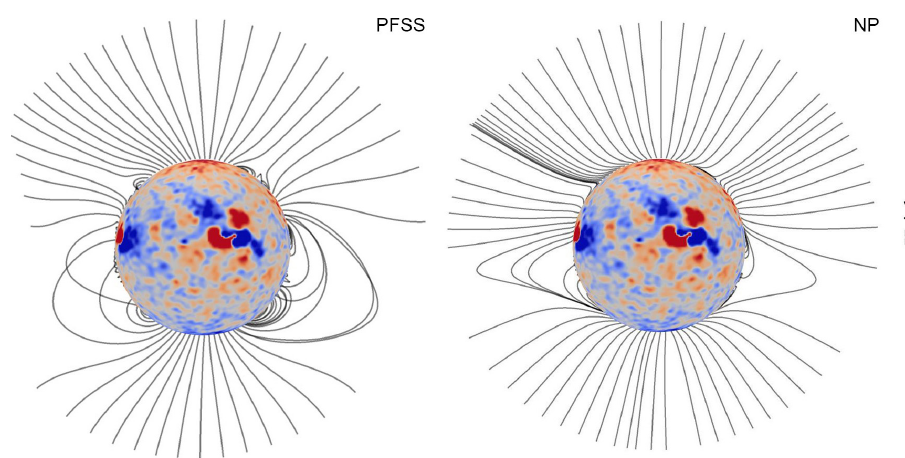
Figure 1. Configuration of magnetic field lines for 21.08.2017 for potential approximation (PFSS) and for non-potential approximation (NP). See text for